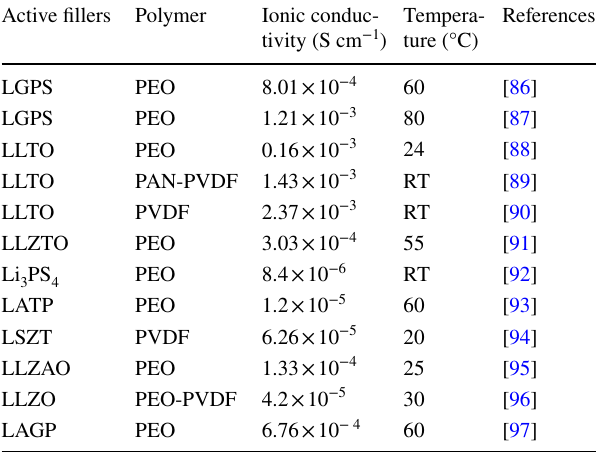
Table 3 CPEs incorporated with active fillers Active fillers